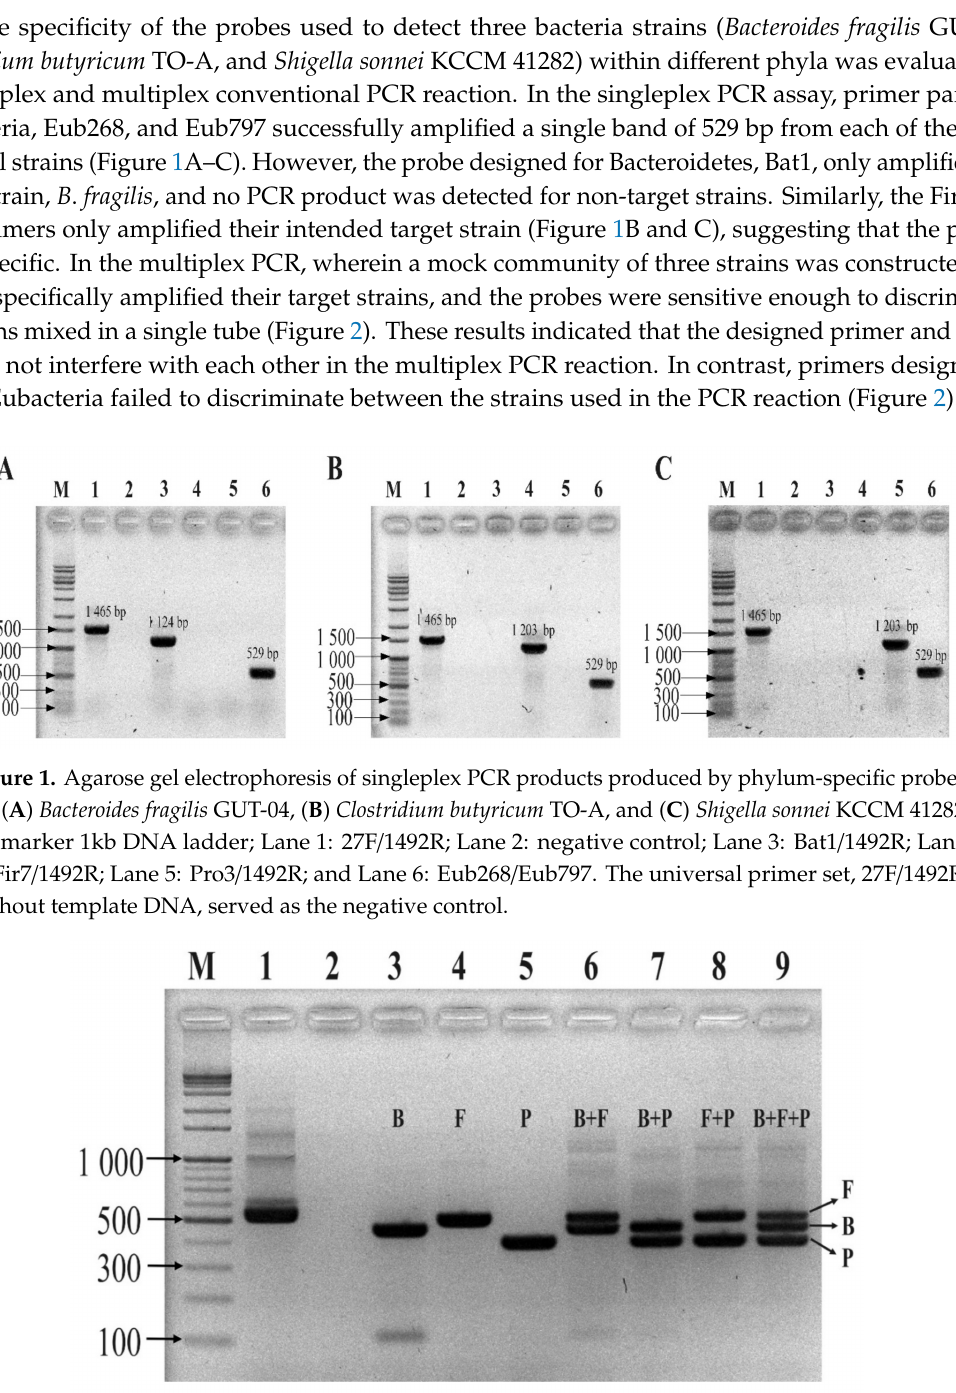
Figure 2. Agarose gel electrophoresis of multiplex PCR products. Letters B, F, and P signify the DNA template extracted from B. fragilis GUT-04, C. butyricum TO-A, and S. sonnei KCCM 41282, respectively. B + F, B + P, F + P, and B + F + P represent mock communities. M: marker 1kb DNA ladder; Lane 1: positive control; Lane 2: negative control; Lane 3: Bat1 + Eub797; Lane 4: Fir7 + Eub797; Lane 5: Pro3 + Eub797; Lane 6: Bat1 + Fir7 + Eub797; Lane 7: Bat1 + Pro3 + Eub797; Lane 8: Fir7 + Pro3 + Eub797; and Lane 9: Bat1 + Fir7 + Pro3 + Eub797. A eubacterial primer set, Eub268 / Eub797, with template DNA from the mock community without probes served as the positive control, and a primer set, 27F / 1492R, without template DNA, served as the negative